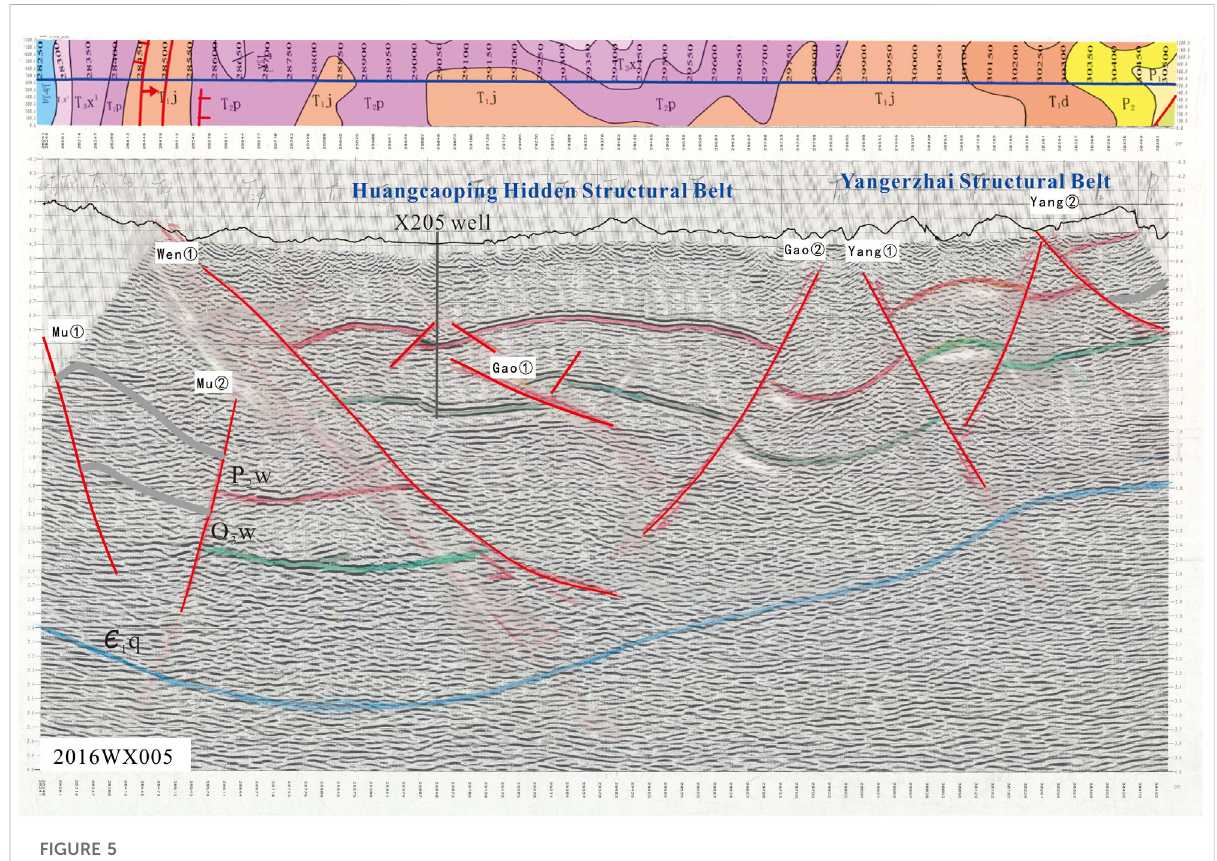
FIGURE 5 B − B ′ seismic-structural pro fi le in the study